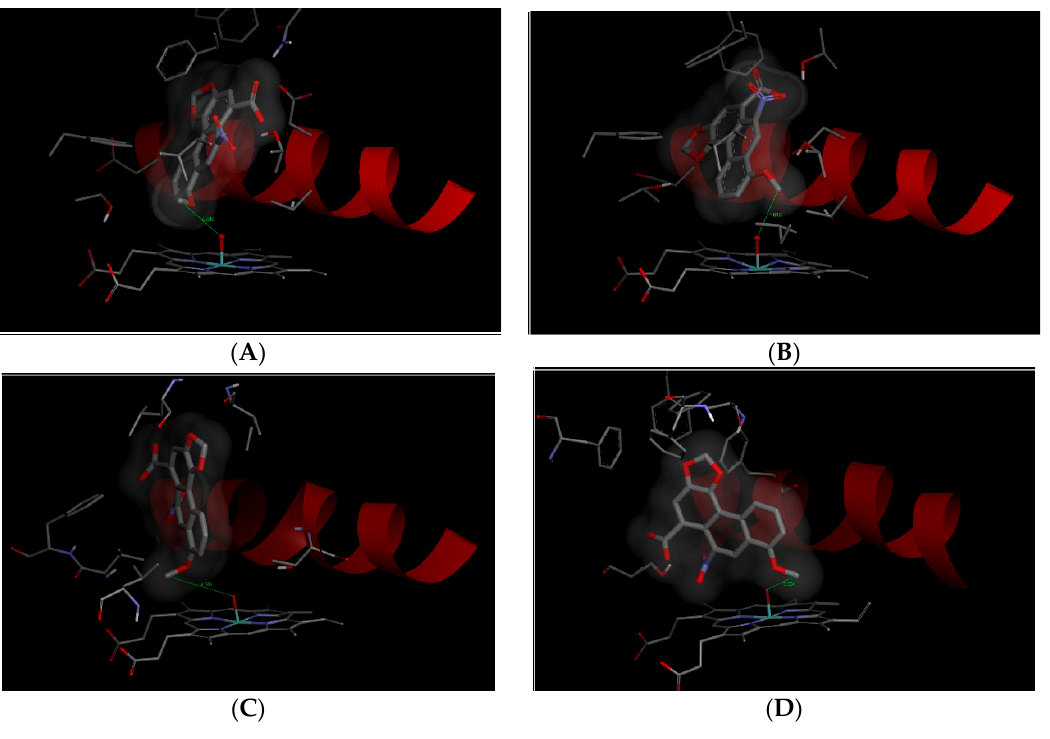
Figure 5. The binding orientations found in molecular docking calculations facilitating O -demethylation of AAI bound in human CYP1A1 ( A ); CYP1A2 ( B ); CYP2C9 ( C ); and CYP3A4 ( D ). AAI, heme and amino acids residues interacting ligand are rendered as bold sticks and sticks, respectively. Red ribbon represents a part of the I helix. respectively. Red ribbon represents a part of the I